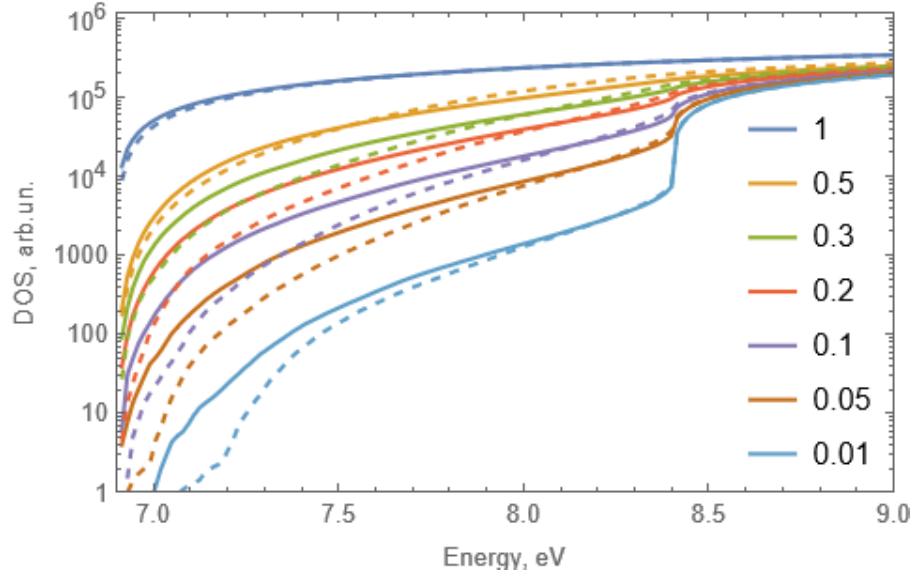
Figure 10. Density of states of a model crystal with different scandium concentrations (indicated in the legend) for the case when correlations in the arrangement of scandium ions are taken into account (solid curves) and in the absence of correlations (dashed curves). The density of states is estimated with the account for potential fluctuations.